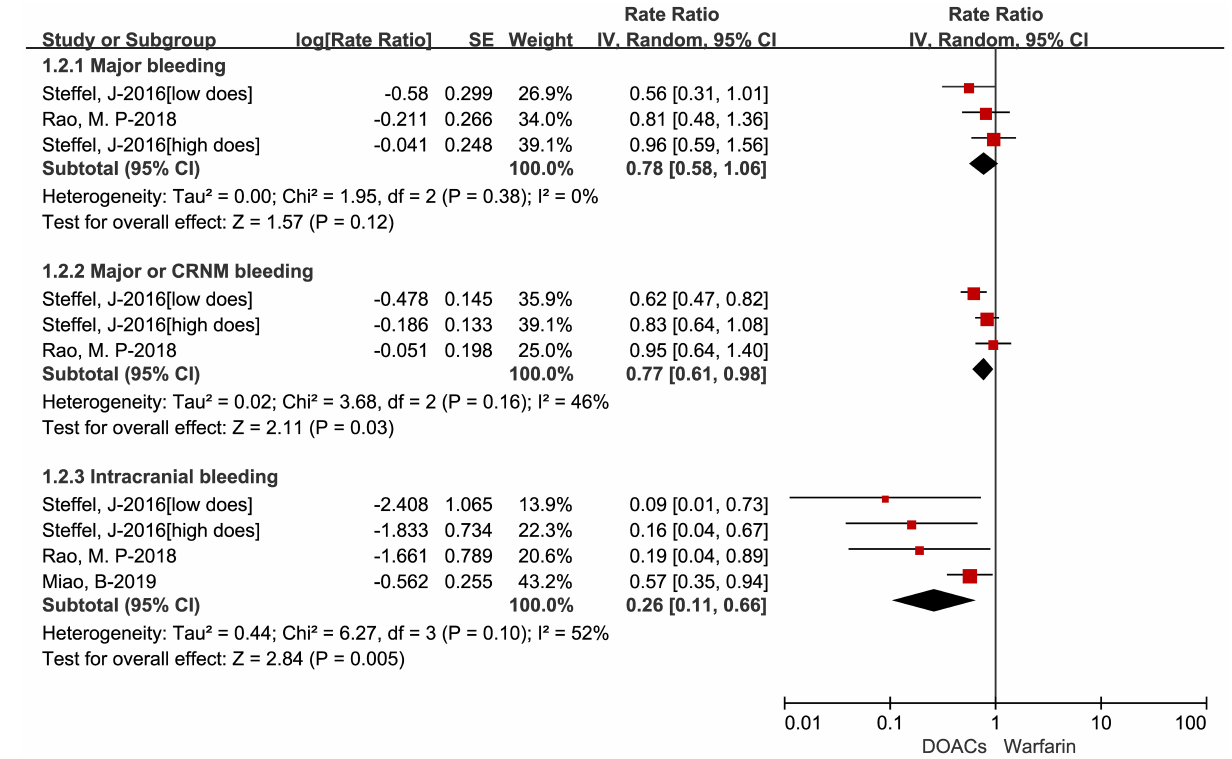
categories, the quality of evidence for outcomes we